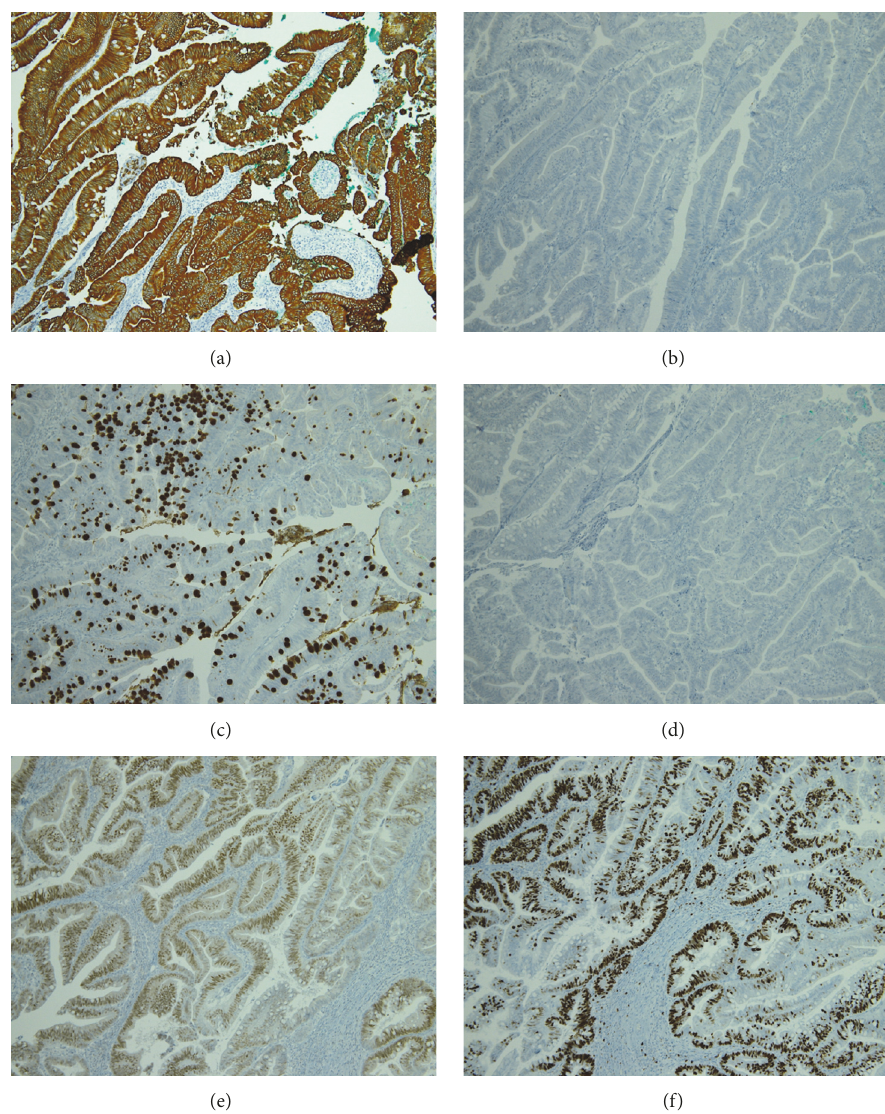
Figure 3: Immunohistochemical feature of the tumor cells. (a, b) Almost all tumor cells are positive for (a) CK20, but the cells are negative for (b) CK7. (c, d) Major proportion of tumor cells is positive for (c) MUC2, but expression of (d) MUC6 is negative. (e) CDX2 is positive for the nucleus of the tumor cells. (f) 40–50% of tumor cells are positive for MIB1.